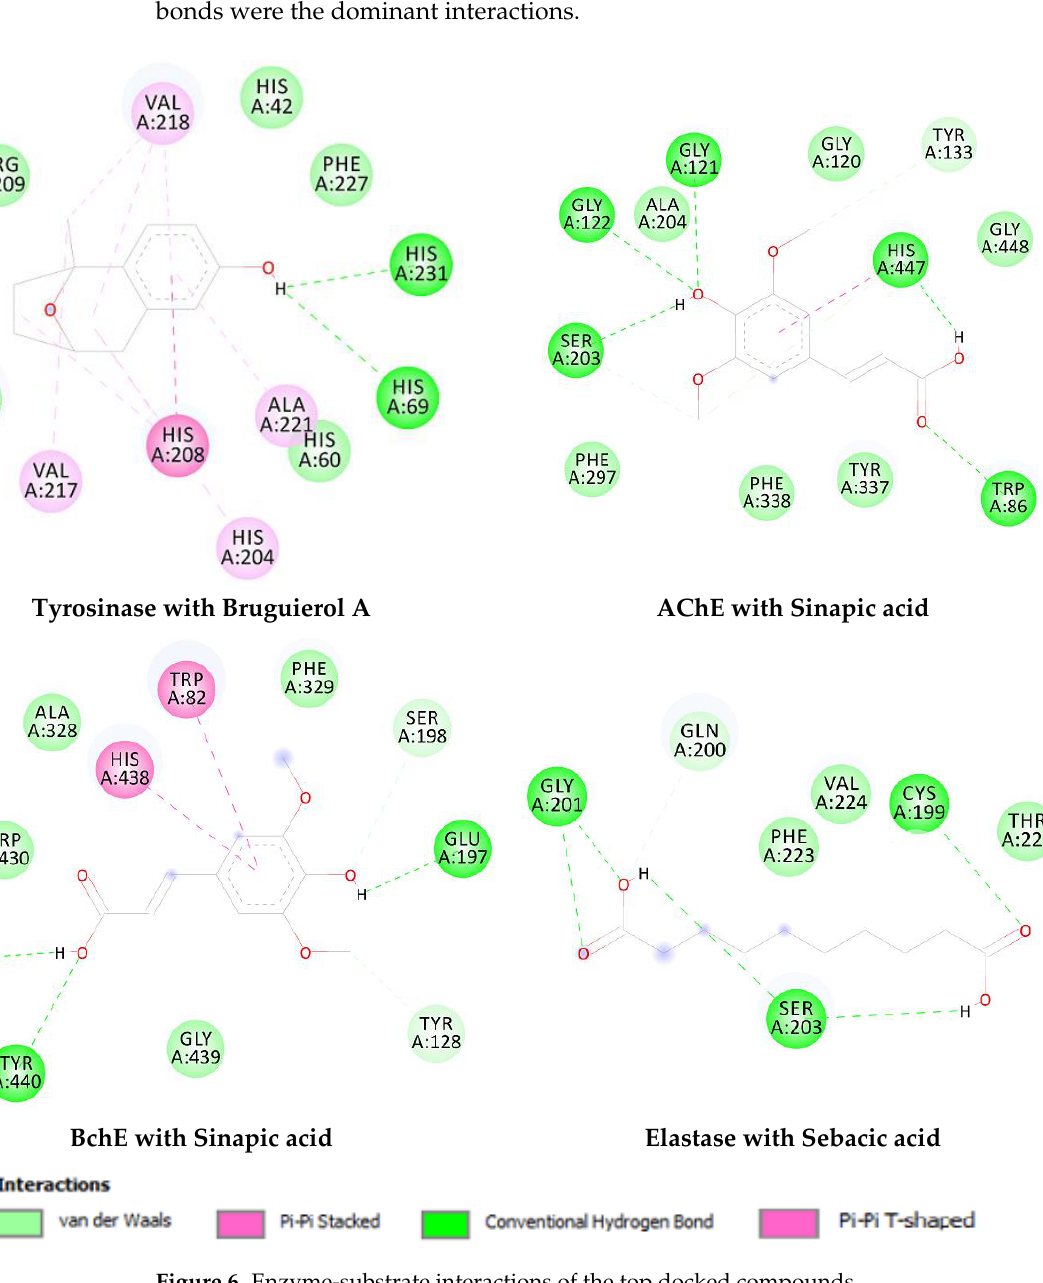
Figure 6. Enzyme-substrate interactions of the top docked compounds.